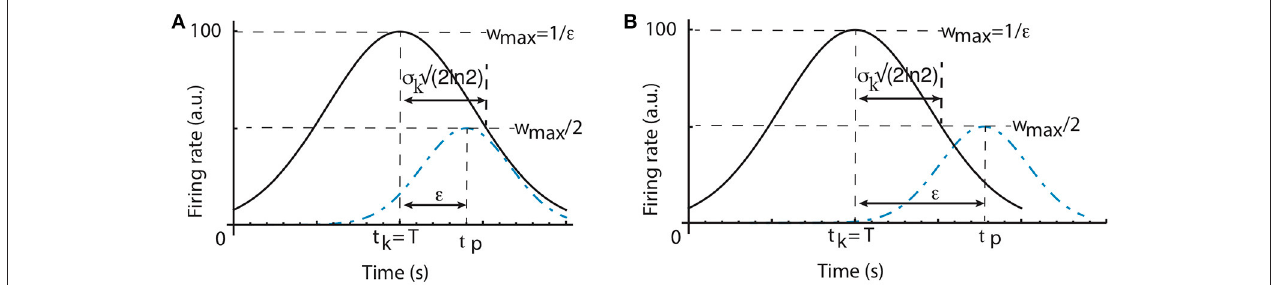
σ k √ 2 ln 2 = 1 1 2 w max = 2 ǫ (regardless the criterion time). =